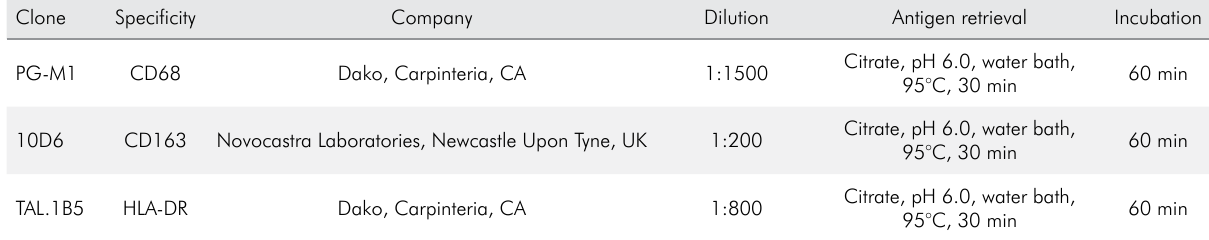
Table 1. Clone, specificity, company, dilution, antigen retrieval, and incubation of the primary antibodies. Clone